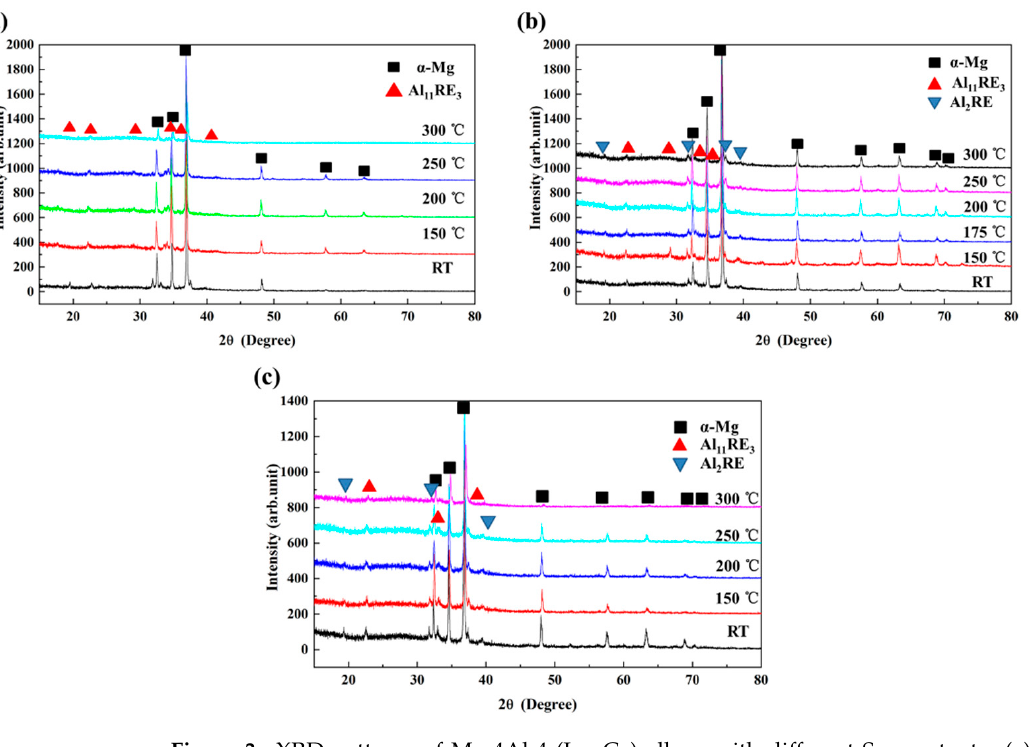
Figure 3. XRD patterns of Mg-4Al-4 (La, Ce) alloys with different Sm contents: ( a ) 0 wt.% Sm; ( b ) 1 wt.% Sm; ( c ) 2 wt.% Sm.